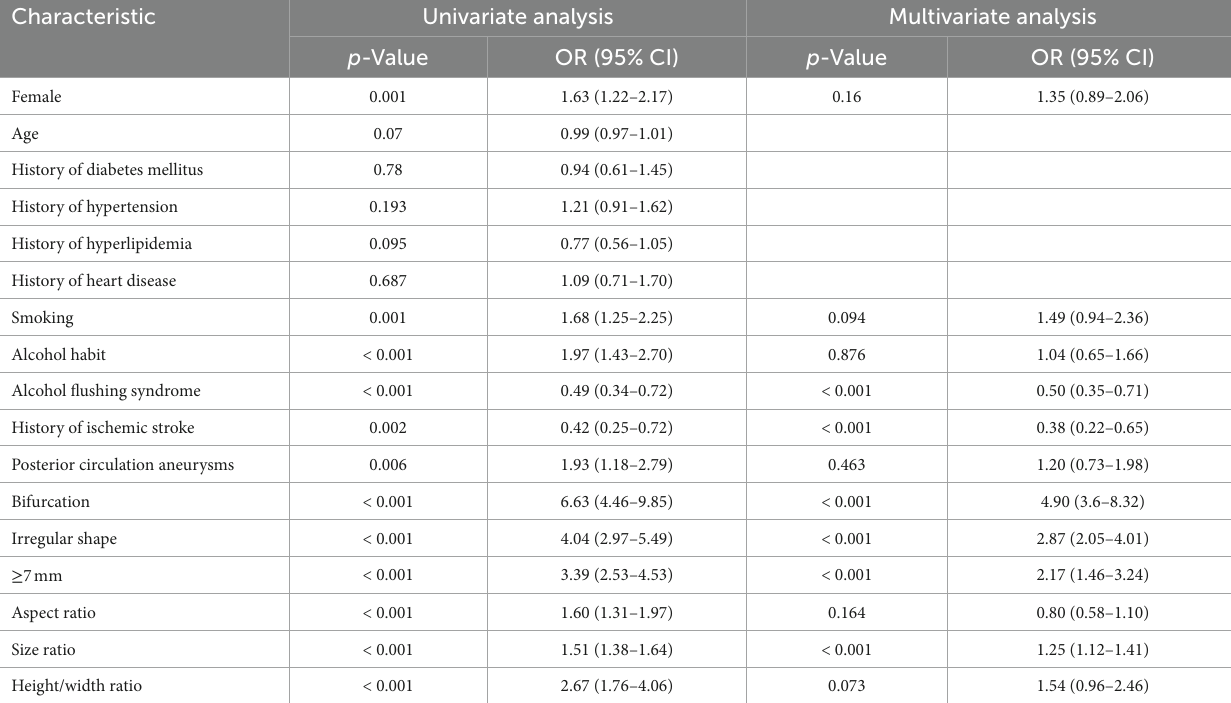
TABLE 5 Results of univariate and multivariate regression analyses.